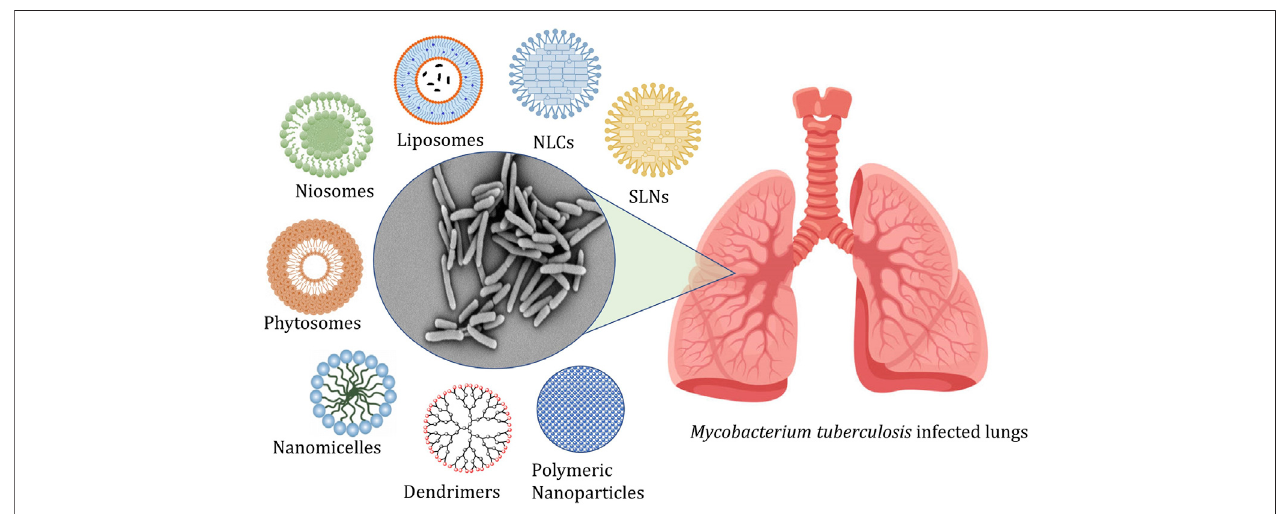
FIGURE 1 | Represents the targeting of alveolar macrophages and granulomas using nanocarriers administered by different routes.